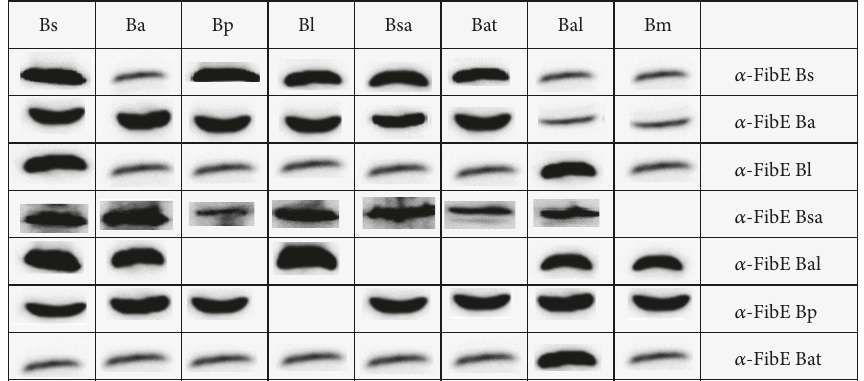
Figure 4: Western blotting using antibody antifibrinolytic enzymes of Bacillus belonging to group I. Bs: B. subtilis , Ba: B. amyloliquefaciens , Bl: B. licheniformis, Bsa: B. safensis, Bal: B. altitudinis , Bp: B. pumilus, Bat: B. atrophaeus .